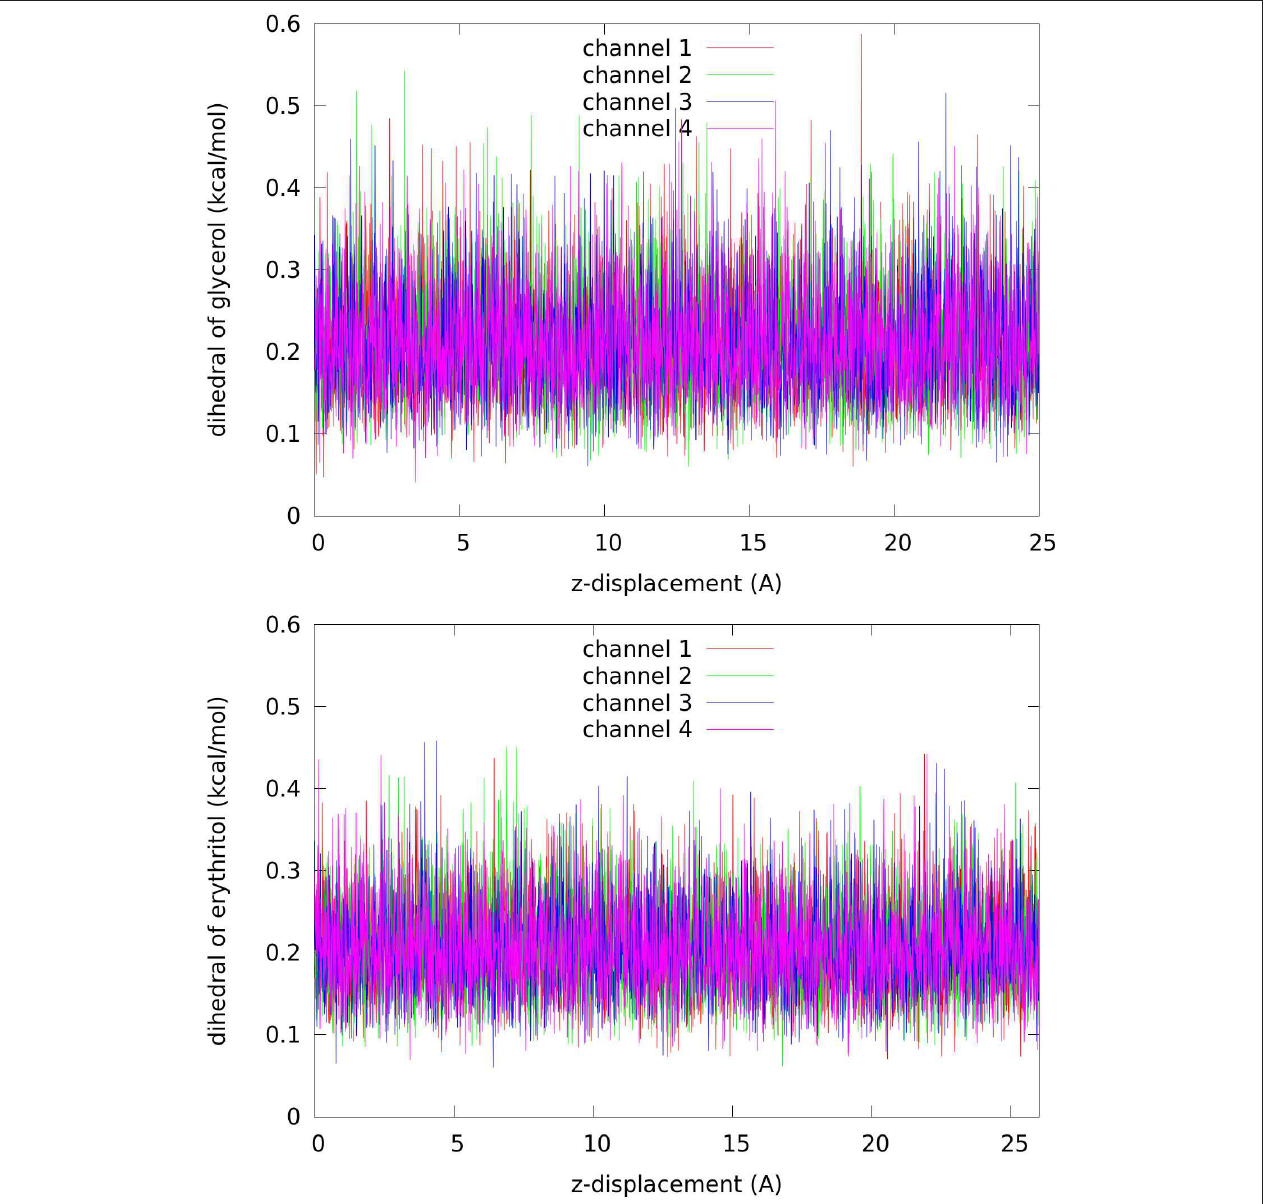
FIGURE 7 | Dihedral energy of glycerol ( Top panel , per each of the 27 dihedrals)/erythritol ( Bottom panel , per each of the 37 dihedrals) along the dissociation path from inside the channel to the cytoplasmic bulk.